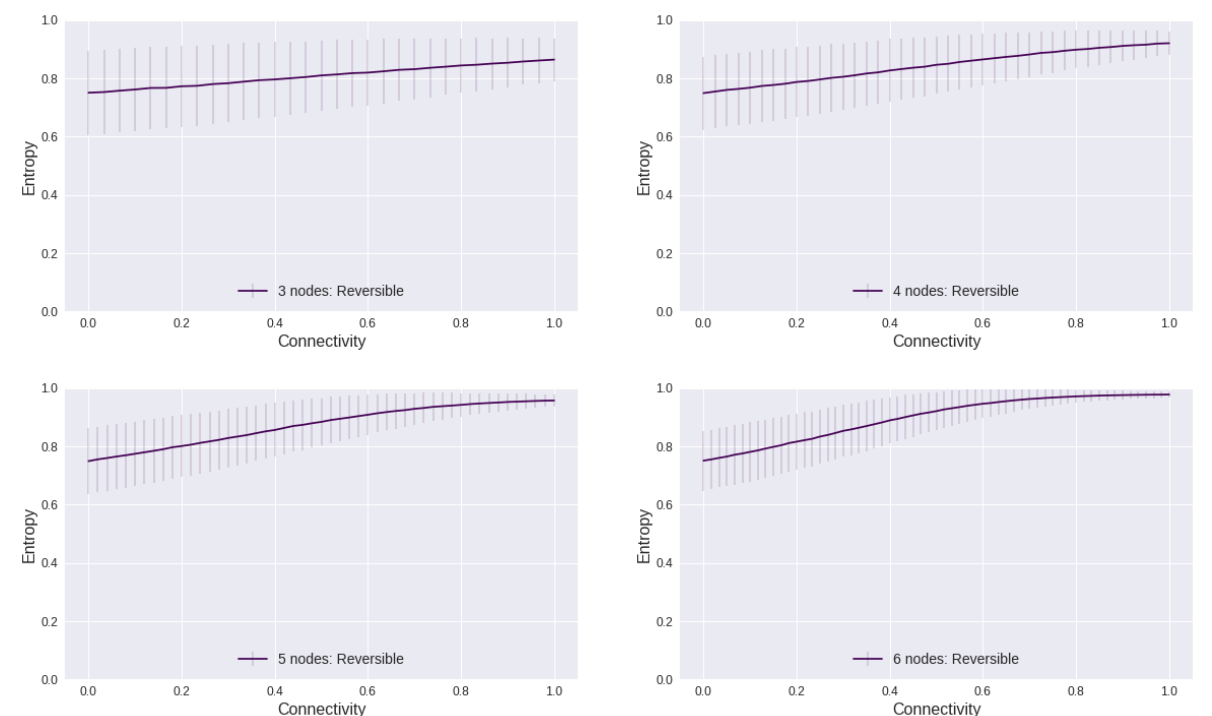
Figure A4. Entropy for RevBNs with 3, 4, 5, and 6 nodes. Connectivity is normalized from the range ( 1, N ) . The entropy was computed from 20,000 realizations.